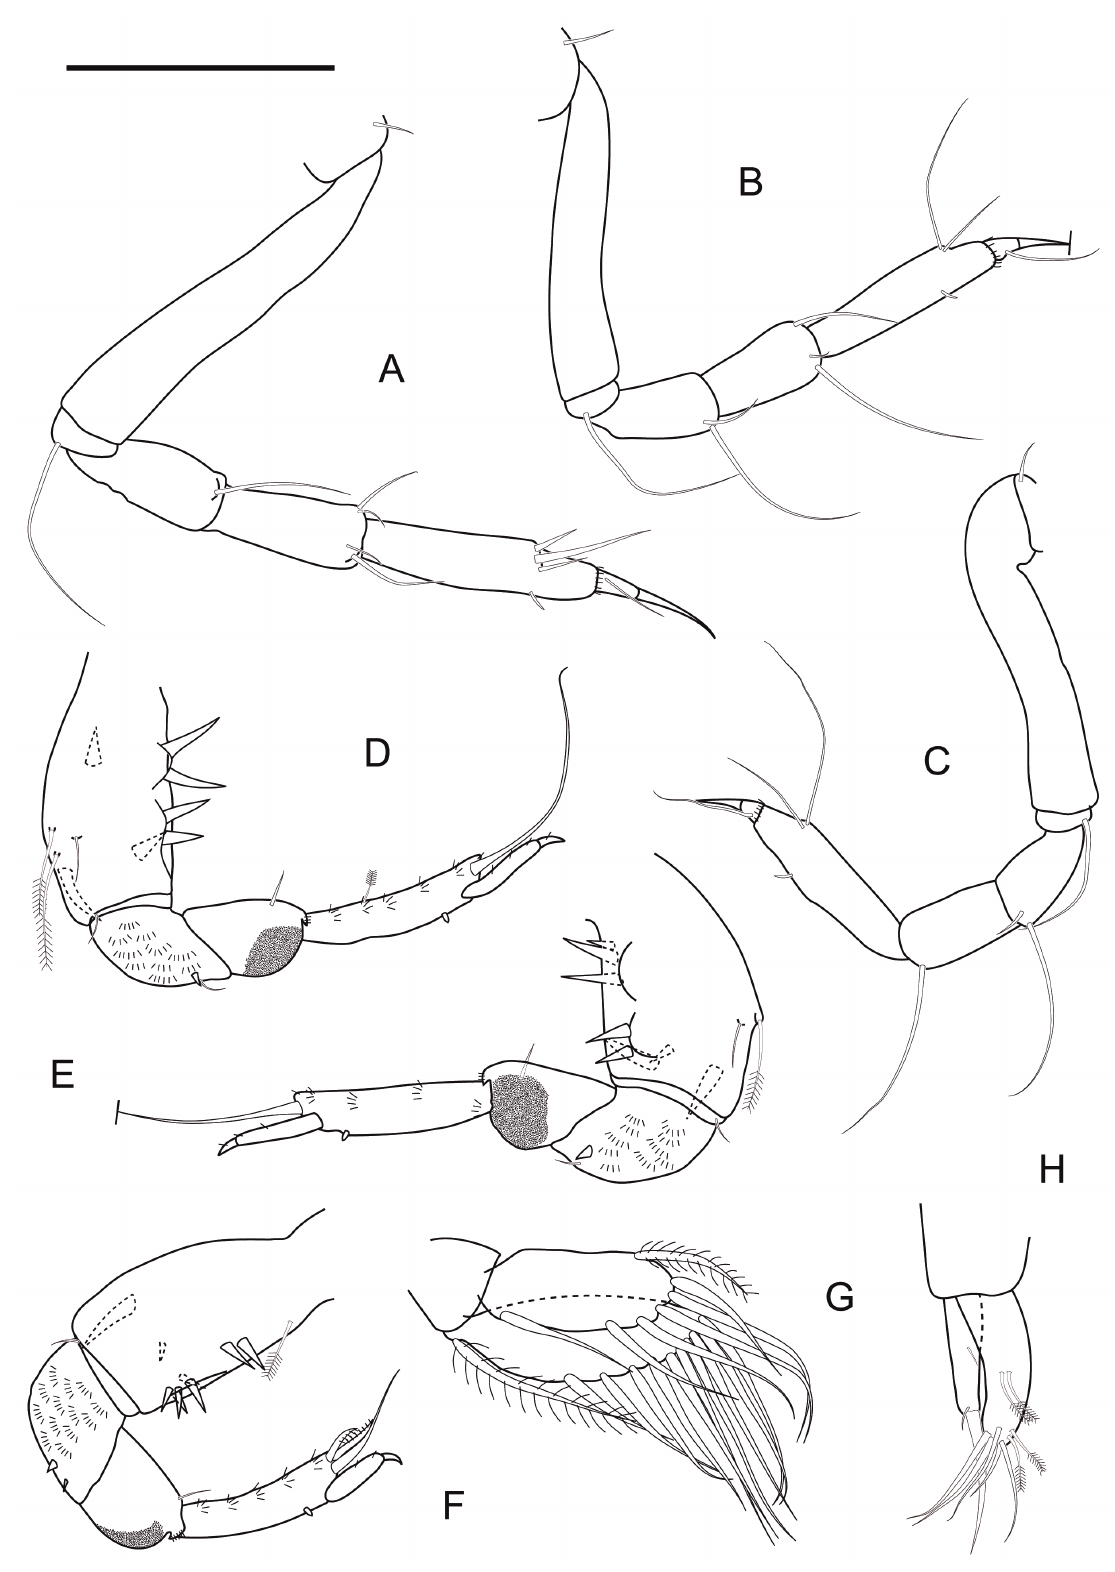
Fig. 19. Typhlotanais spinibasis sp. nov., paratype (MZUSP 32893), ♀, dissected. A–F . Pereopods 1–6. G . Pleopod. H . Uropod. Scale bar = 0.1